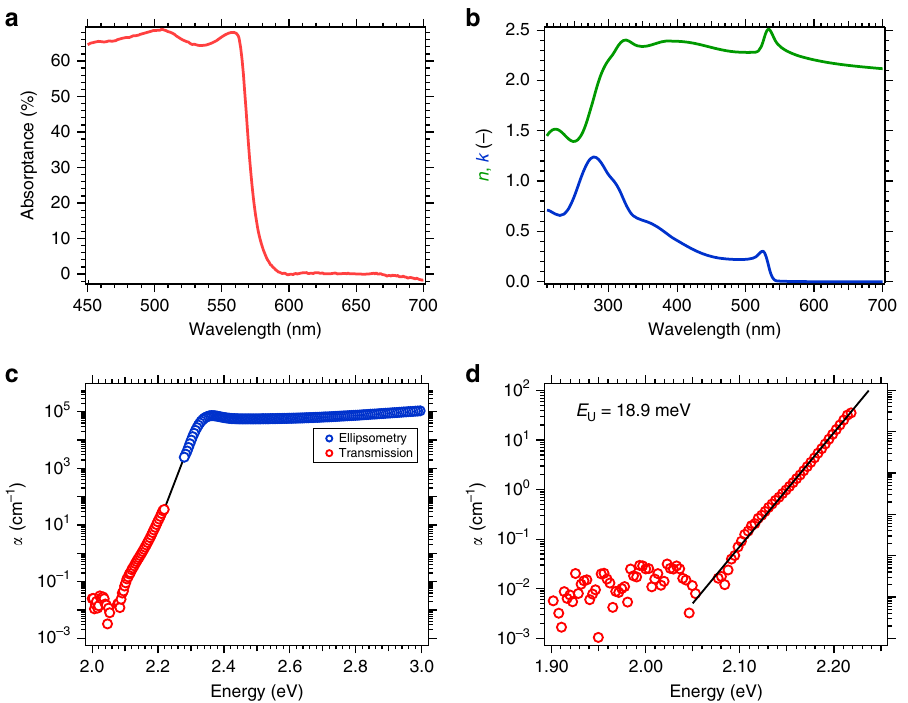
Fig. 1 Absorption properties of a CH 3 NH 3 PbBr 3 single crystal. a Absorptance spectrum calculated from total transmittance and re fl ectance. Below 560 nm, no light is detected in transmission mode (Supplementary Fig. 1). b Optical constants ( n, k ) measured by ellipsometry. c Absorption coef fi cient obtained by the combination of transmission ( red circles ) and ellipsometry ( blue circles ) data. For transmission data α is calculated from Beer-Lambert law (crystal thickness 2.13 mm) and for ellipsometry from the attenuation coef fi cient k (see main text). d Estimation of the Urbach energy by fi tting the exponential tail of the absorption